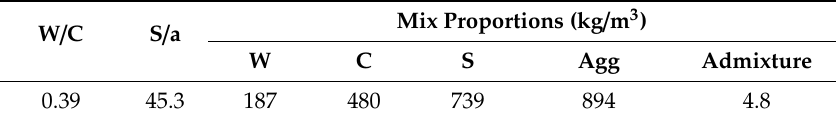
Table 3. Concrete mixture design and material quantities.